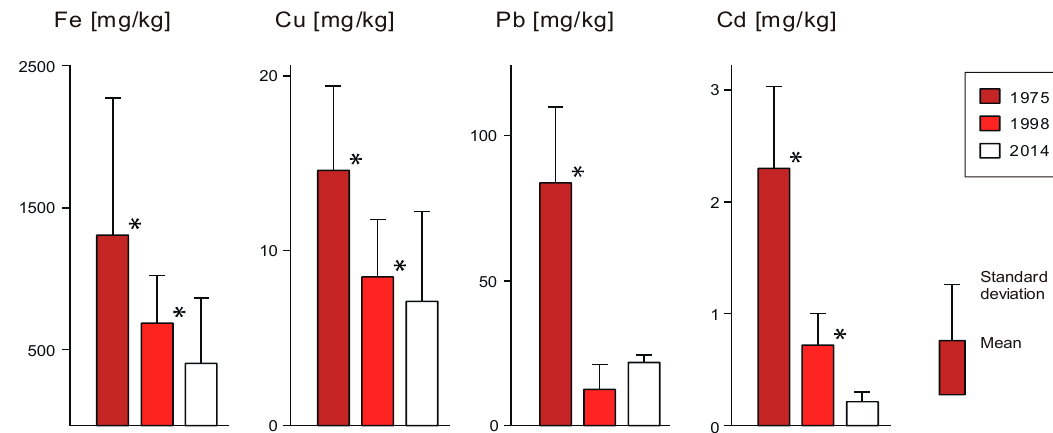
Figure 8. Temporal changes in concentration of heavy metals in Pleurozium schreberi from Niepołomice Forest. * Statistically significant differences; p = 0.05, Wilcoxon test (after [64], changed).